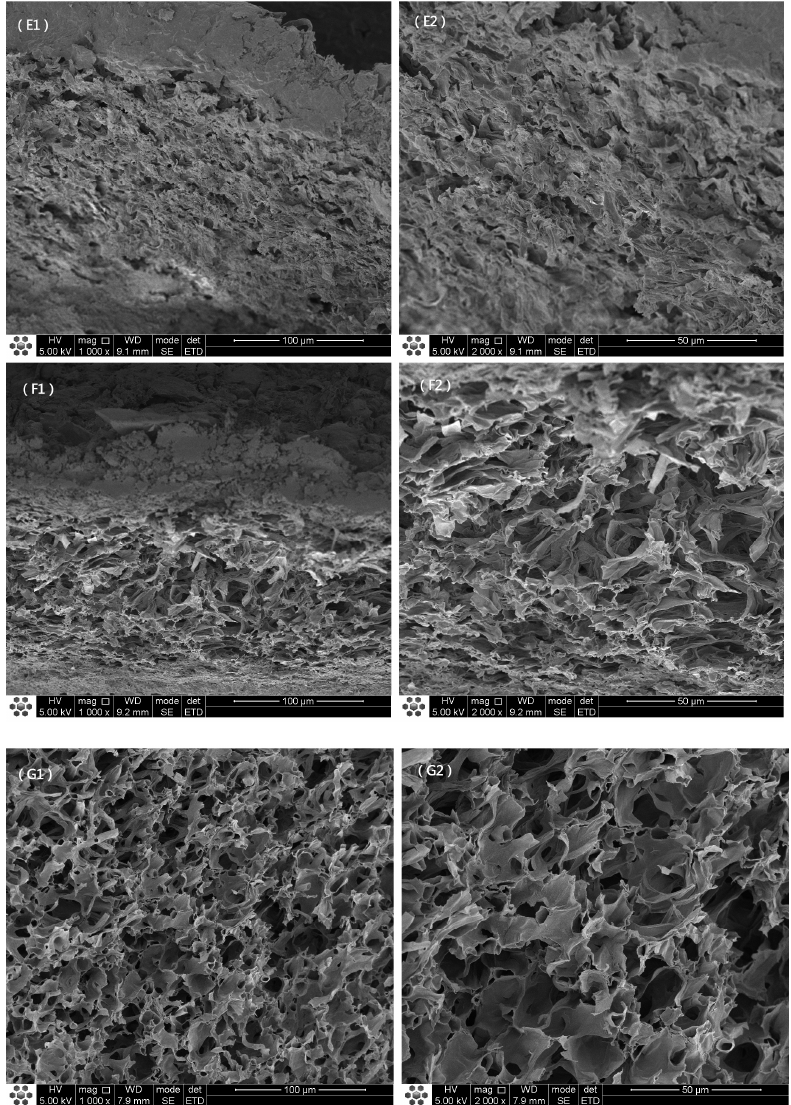
Figure 2. Scanning electron micrographs of different drying methods of O. raphanipes . The magnifi- cation was set as × 1000 and 2000: ( A1 , A2 )—ultrasonic-assisted 60 °C hot air drying; ( B1 , B2 )—60 °C hot air drying; ( C1 , C2 )—ultrasonic-assisted 80 °C hot air drying; ( D1 , D2 )—80 °C hot air drying; ( E1 , E2 )—microwave drying; ( F1 , F2 )—vacuum microwave drying; ( G1 , G2 )—vacuum freeze drying.